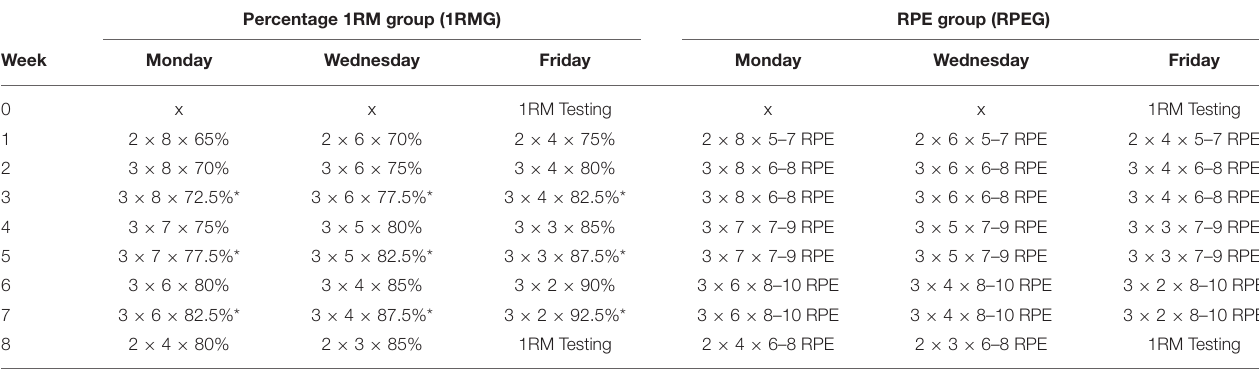
TABLE 2 | Summary of training